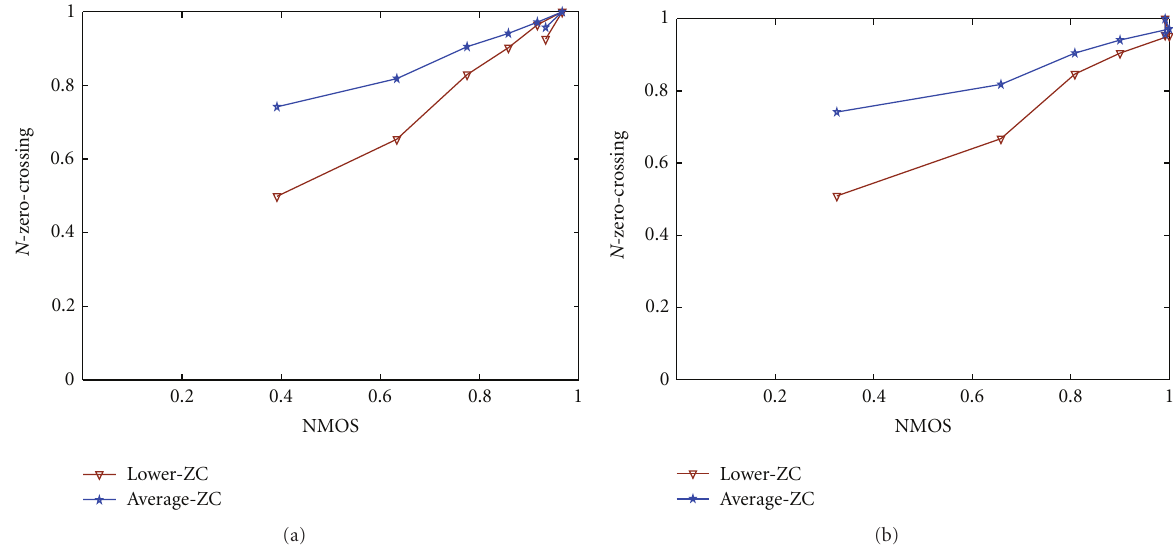
Figure 6: Normalized MOS versus zero-crossing for di ff erent Cattle image pairs. (a) L, R: QS55-QS10, QS55-QS15, QS55-QS27, QS55-QS37, QS55-QS55, QS55-QS79, and QS55-Ref, (b) L, R: Ref-QS10, Ref-QS15, Ref-QS27, Ref-QS37, Ref-QS55, Ref-QS79, and Ref-Ref.